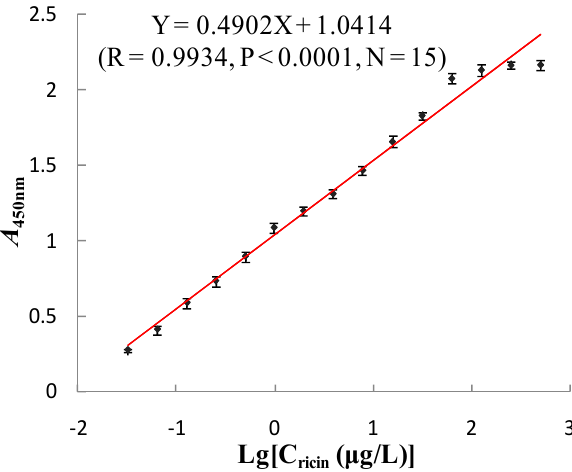
Figure 8. Determination activity of the SPA-coated gold-magnetic nanoparticles functionalized capturing probe.